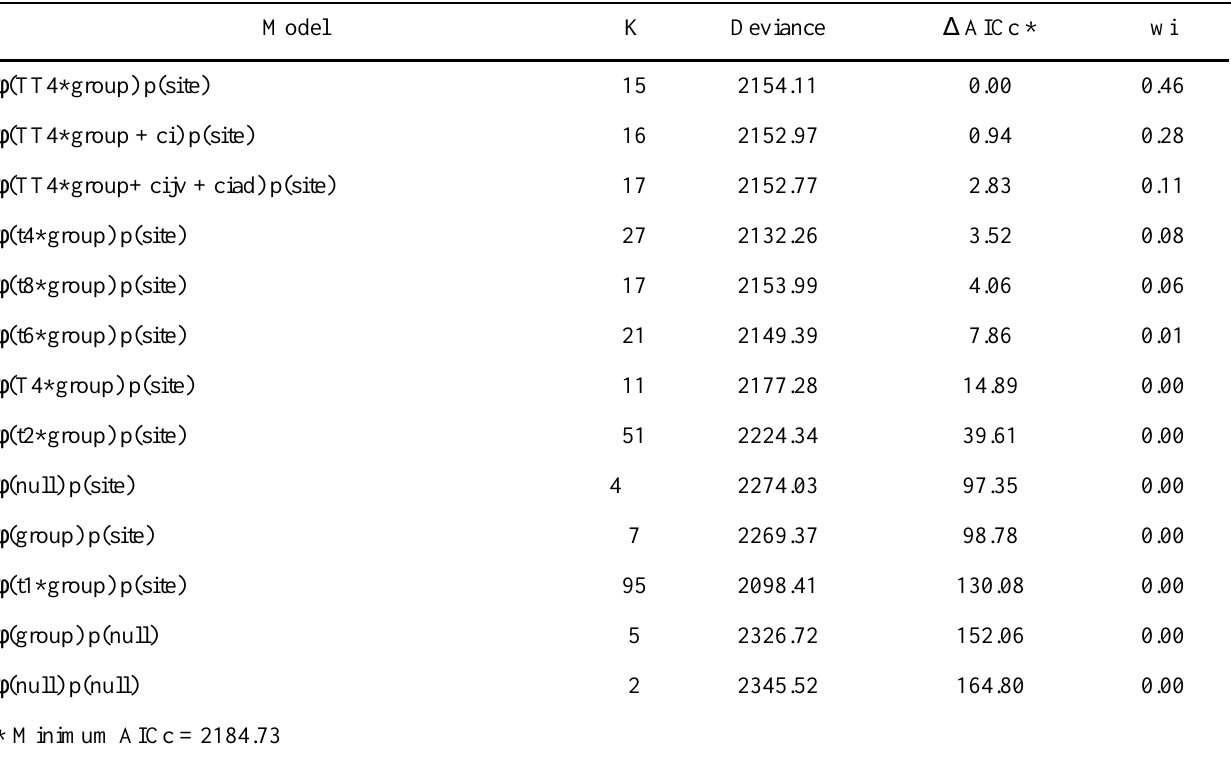
Table 2. Model selection results for apparent survival for 293 fall-migrating Least Sandpipers in the Lower Mississippi River Alluvial Valley during Fall 2002. Models were ranked by ascending D AICc. Time is represented by t followed by the constancy interval. The terms ciad, ci, and cijv represent condition index of adults, condition index of all birds, and condition index of juveniles, respectively. T and TT represent linear and quadratic time trends, respectively. Model